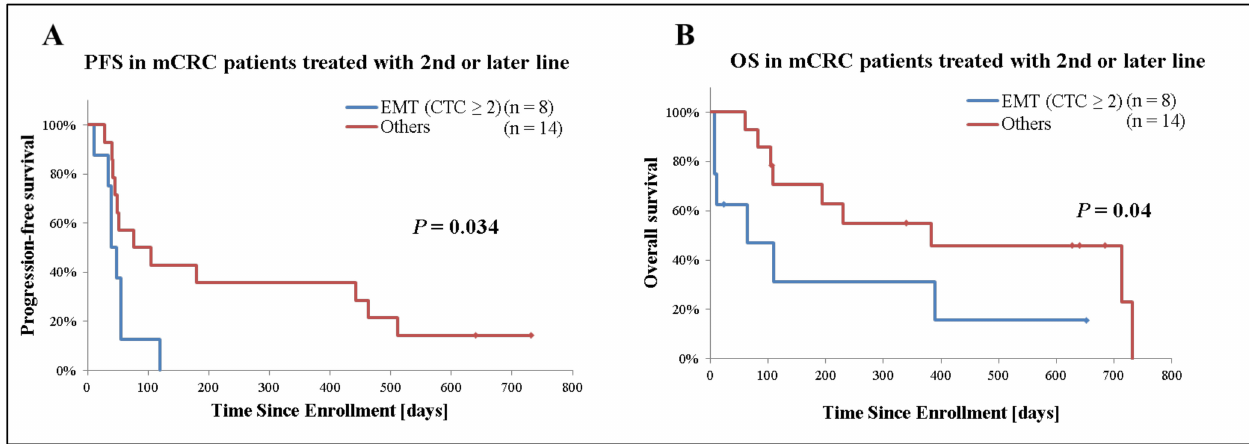
Figure 4. Kaplan–Meier plots of 22 mCRC cases receiving second- or later-line treatment stratified by presence of EMT CTCs. ( A ) Analysis of progression-free survival (PFS), ( B ) overall survival (OS). Patient receiving second- or later-line of treatment were grouped based on the presence and number of EMT CTCs. Patients who only had detectable EMT CTCs and 2 or more CTCs were categorized as “EMT (CTC ≥ 2)”. ‘Others’ indicates patients with <2 EMT CTCs or no detectable CTCs. p -values were calculated with the Generalized Wilcoxon test and are shown in the